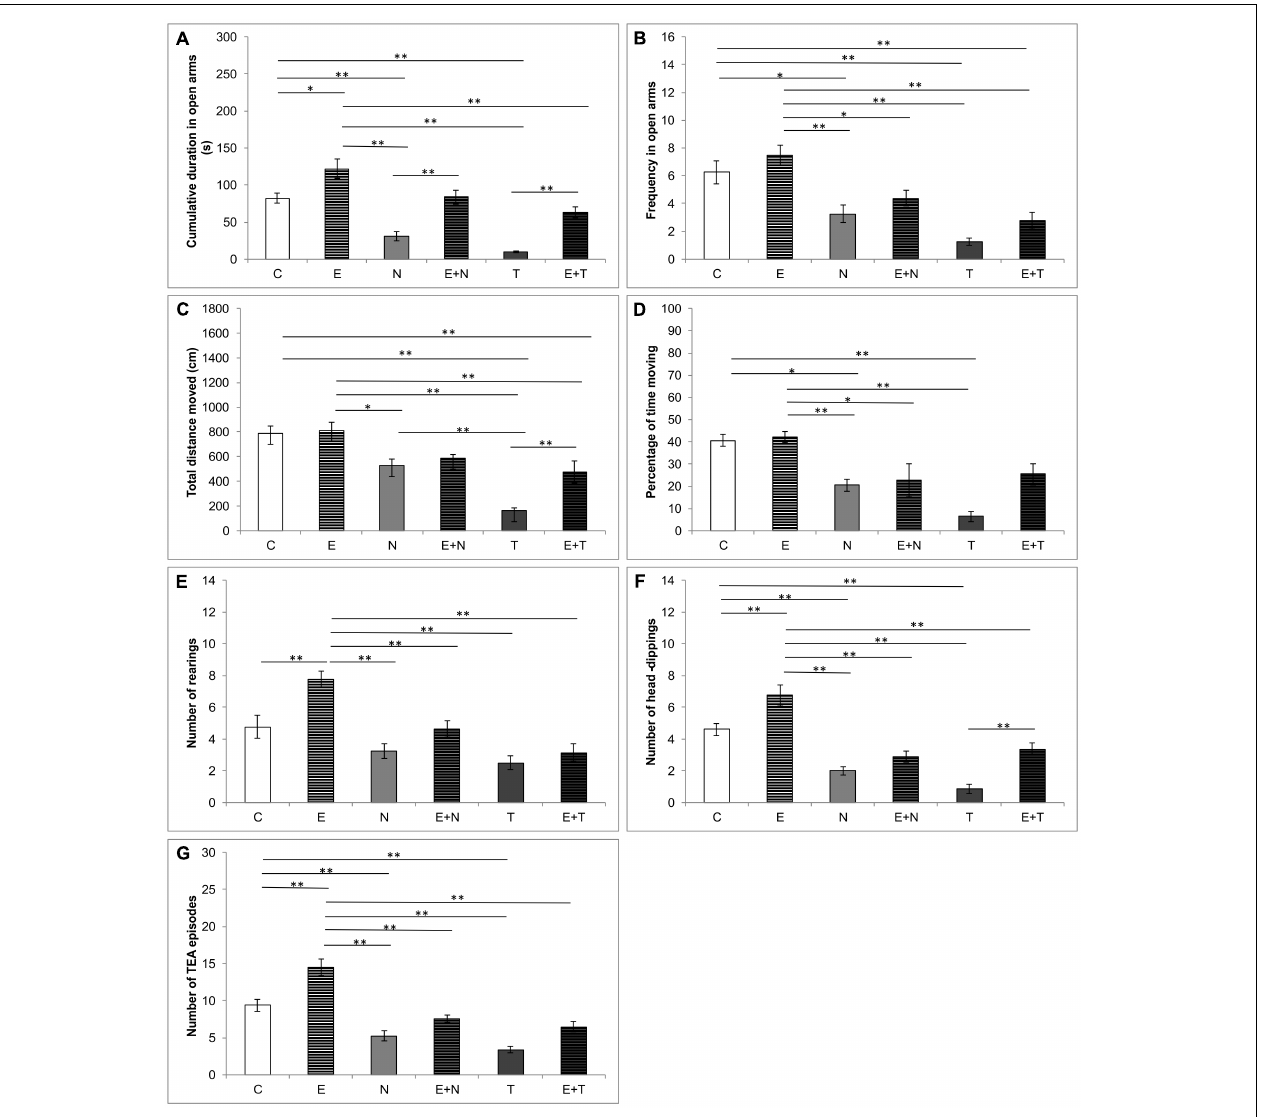
FIGURE 2 | Parameters calculated from the elevated plus maze test. (A) Cumulative duration in open arms; (B) Frequency in open arms; (C) Total distance moved; (D) Percentage of time moving; (E) Number of rearings; (F) Number of head-dippings, (G) Number of TEA episodes; (C, control group; E, exercise group; N, nandrolone-decanoate group; E+N, exercise plus nandrolone-decanoate group; T, testosterone-enanthate group; E+T, exercise plus testosterone-enanthate group). Bars represent means ± SEM, ∗ denotes a significant difference p ≤ 0.025, ∗∗ denotes a significant difference p ≤